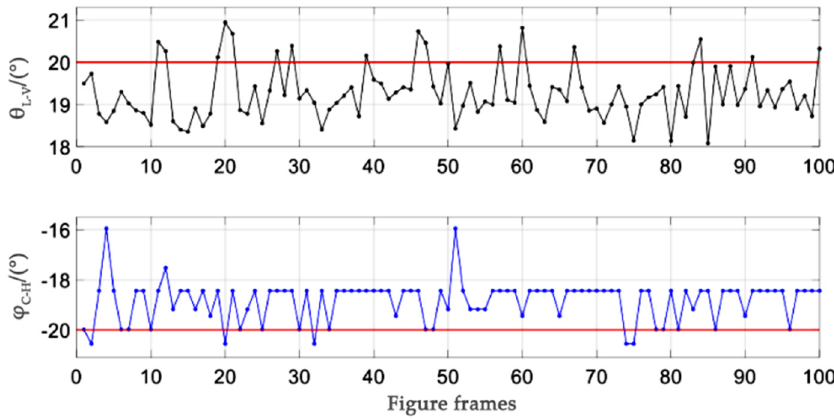
Figure 9. θ = 20 ◦ , ϕ = − 20 ◦ detection value respectively through L–V and C–H Figure 9. θ = 20°, φ = − 20° detection value respectively through L − V and C − H methods.